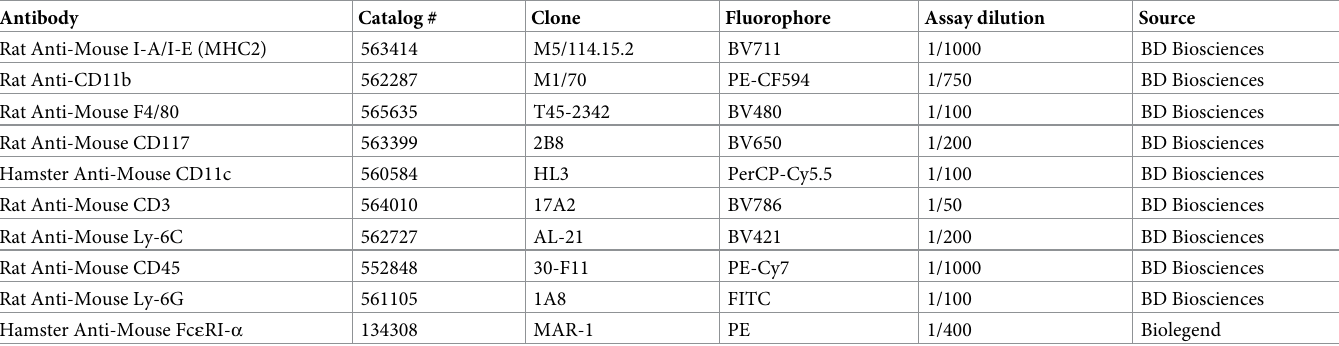
Table 1. Flow cytometry antibody